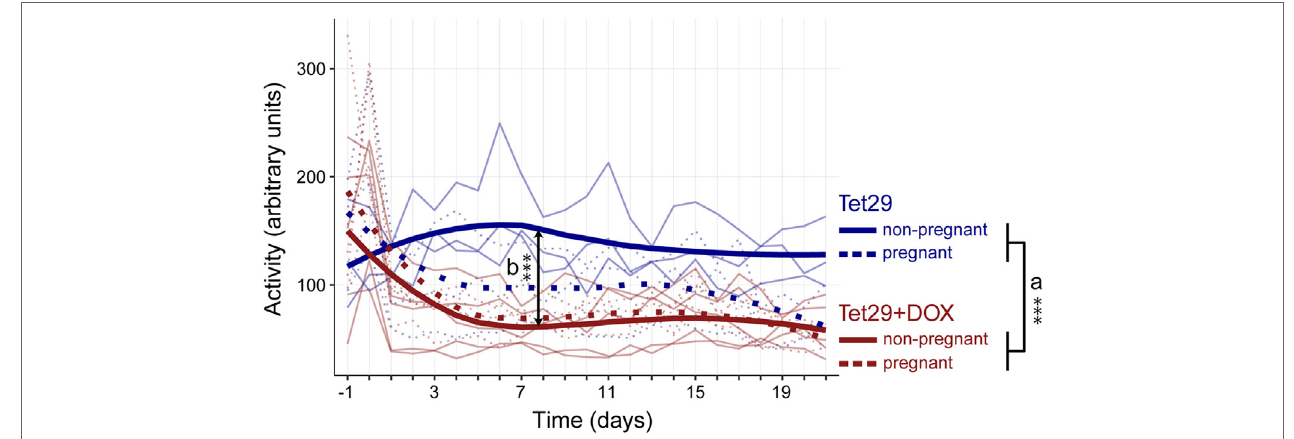
FigUre 3 | Continuous monitoring of activity during pregnancy. Shown is the mean activity of each rat per group over time. DOX = Doxycyclin; n = 3 non-pregnant Tet29 rats, n = 3 pregnant Tet29 rats, n = 5 non-pregnant Tet29 + DOX rats, and n = 5 pregnant Tet29 + DOX rats. The bold line/symbols show the smoothed averaged course of all animals within a group (LOESS). The days refer to pregnancy or the corresponding period in non-pregnant animals. (a) Diabetic Tet29 + DOX rats, both pregnant and non-pregnant, display a lower activity than normoglycemic Tet29 rats, both pregnant and non-pregnant (repeated measures ANOVA). (b) In addition, non-pregnant Tet29 + DOX rats had a lower activity than non-pregnant Tet29 rats (repeated measures ANOVA). There is no difference in activity between pregnant Tet29 + DOX rats and pregnant Tet29 rats (repeated measures ANOVA). Pregnancy did not influence activity in diabetic Tet29 + DOX rats (repeated measures ANOVA), but there was a trend that pregnancy decreased activity in normoglycemic Tet29 rats (repeated measures